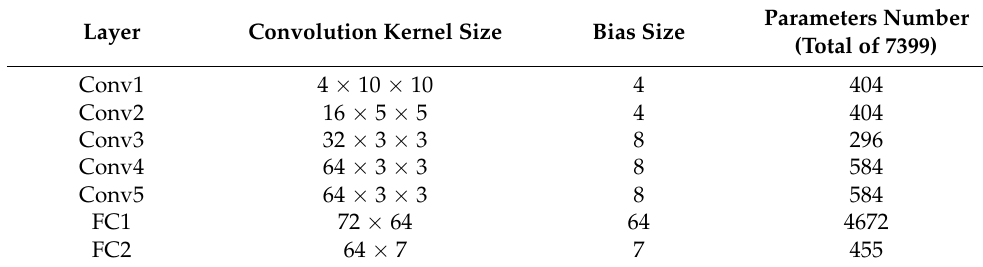
Table 8. Description of optimal parameters on the self-built